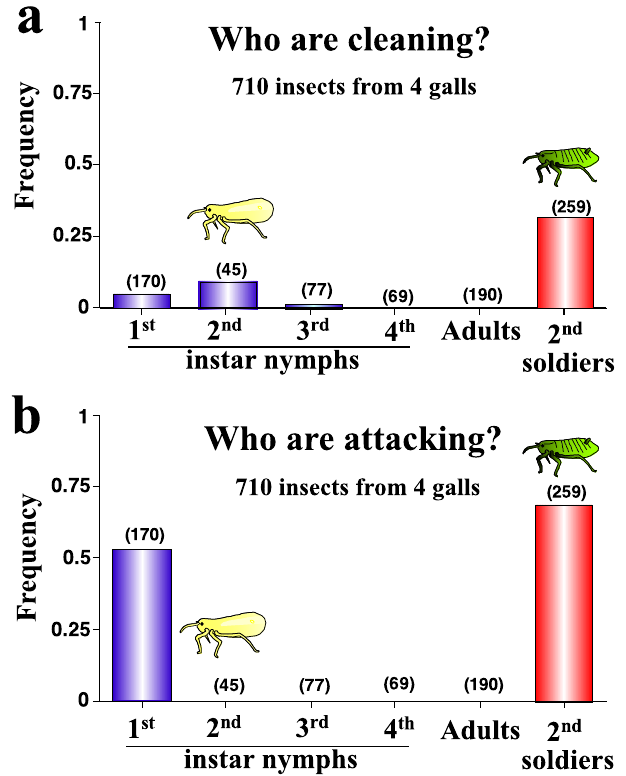
Figure 2. Social behaviors performed by gall inhabitants of T. styraci on artificial diet plates. ( a ) Frequency of cleaning behavior. A statistically significant difference was detected between soldiers and second instar non-soldier nymphs (Chi-square test; P < 0.01). ( b ) Frequency of attacking behavior. Statistically significant differences were identified between soldiers and second instar non-soldier nymphs (Chi-square test; P < 0.0001) and between soldiers and first instar nymphs (Chi-square test; P < 0.01). In total, 710 insects from 4 galls, which contained first, second, third and fourth instar nymphs, unwinged adults, and second instar soldiers, were subjected to behavioral